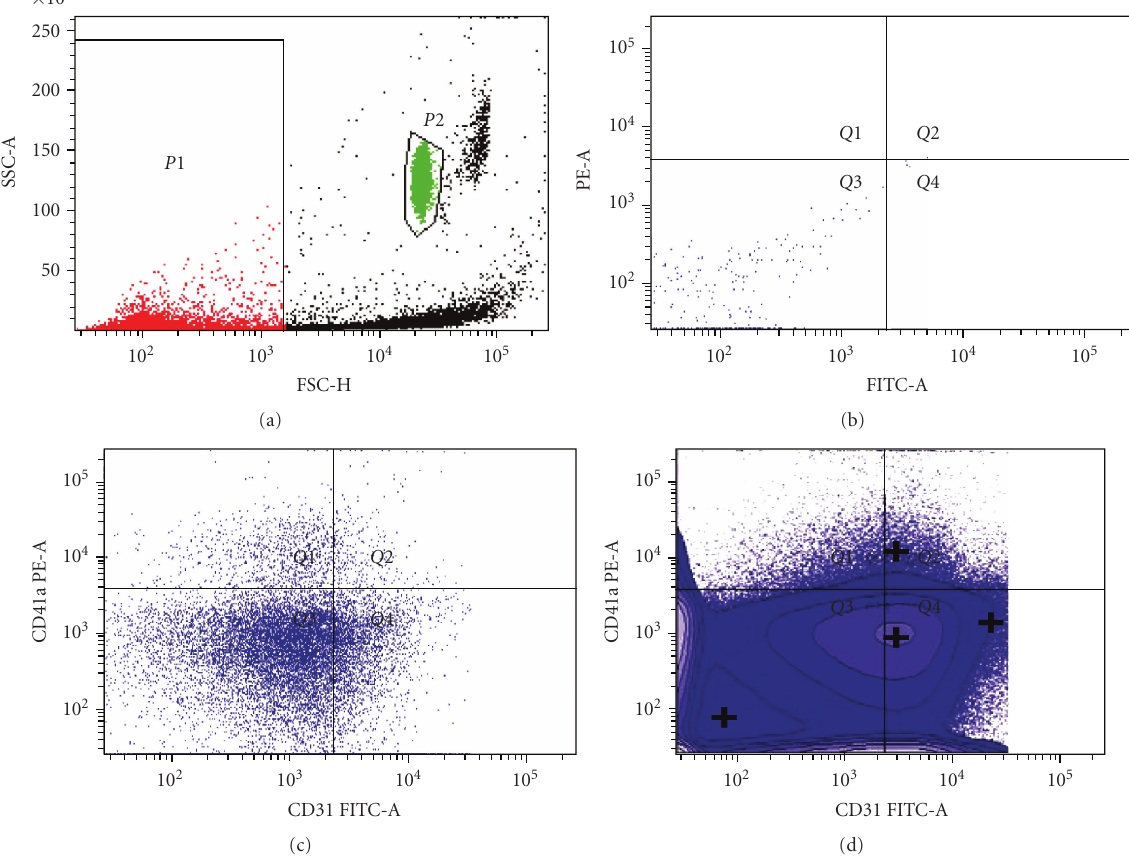
Figure 2: Gating protocol. (a) Bivariant analysis e ffi ciently distinguished EMPs from quantitation beads. (b) EMPs from activated EC culture had negligible autofluorescence on FITC/PE channels. (c) Two-color staining with CD41a enables CD31+ EMPs to be segregated from platelet microparticles. (d) Logicle displays provide improved representation of the EMP population with minimal